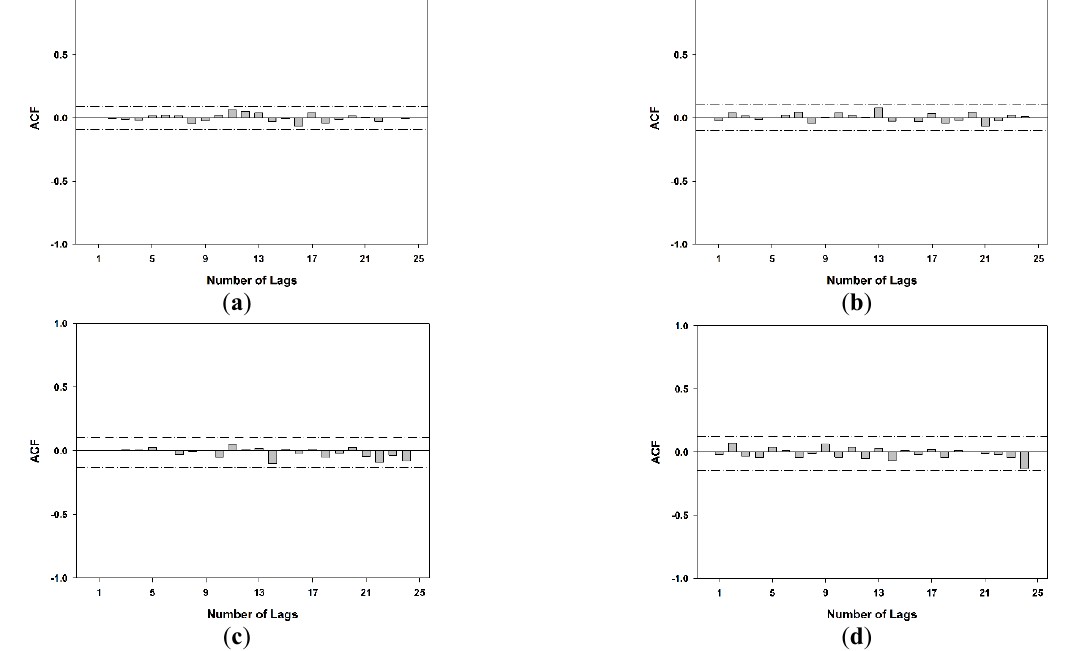
Figure 6. Autocorrelation function (ACF) of residuals of Al Ghazalah City as a best-fitted model for data series of standardized precipitation evapotranspiration index (SPEI) at different time scales during the period of 1950–2010; ( a ) 3-SPEI, ( b ) 6-SPEI, ( c ) 12-SPEI and ( d )